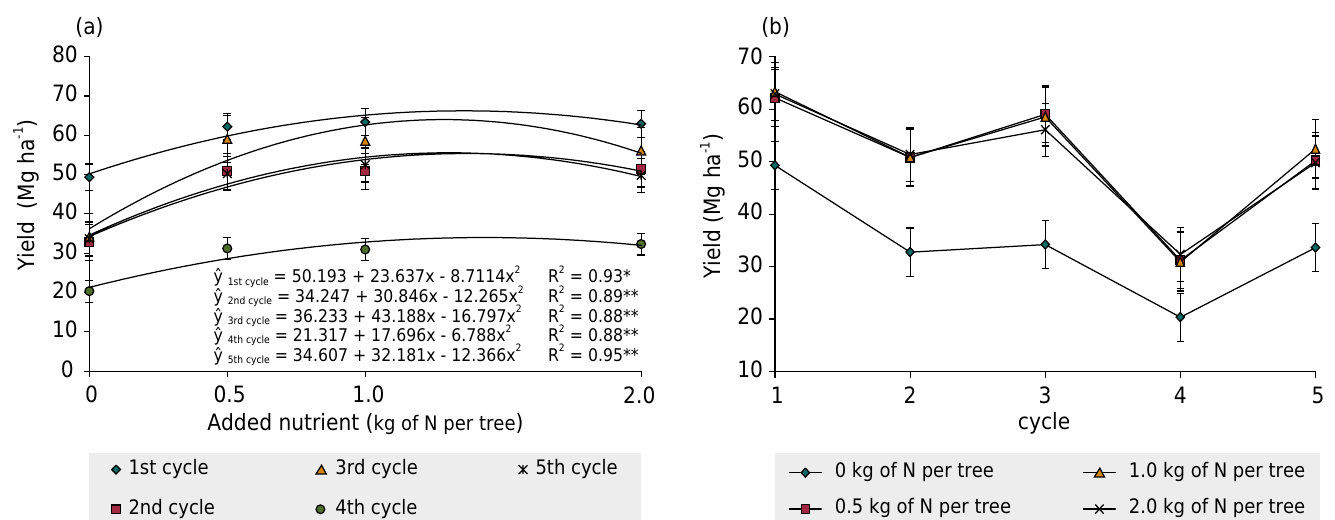
Figure 2. ‘Paluma’ guava yield in response to nitrogen fertilization (a) and seasonal change of production during the experimental period (b) for five production cycles. Vertical bars at each point represent the standard error of the mean.